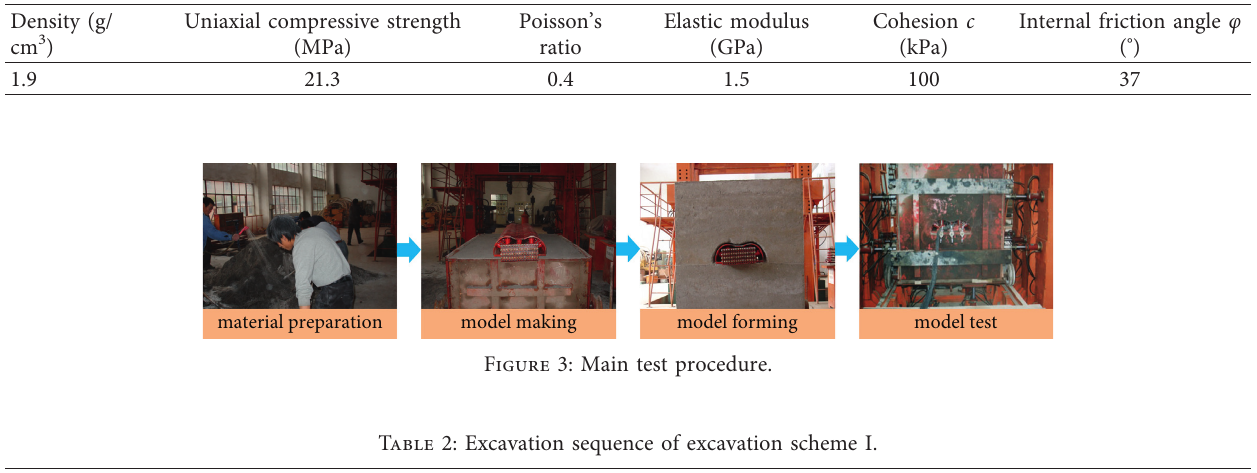
Figure 2: The improved Instron electrohydraulic servo fatigue testing machine. Table 1: Main physical and mechanical parameters of surrounding